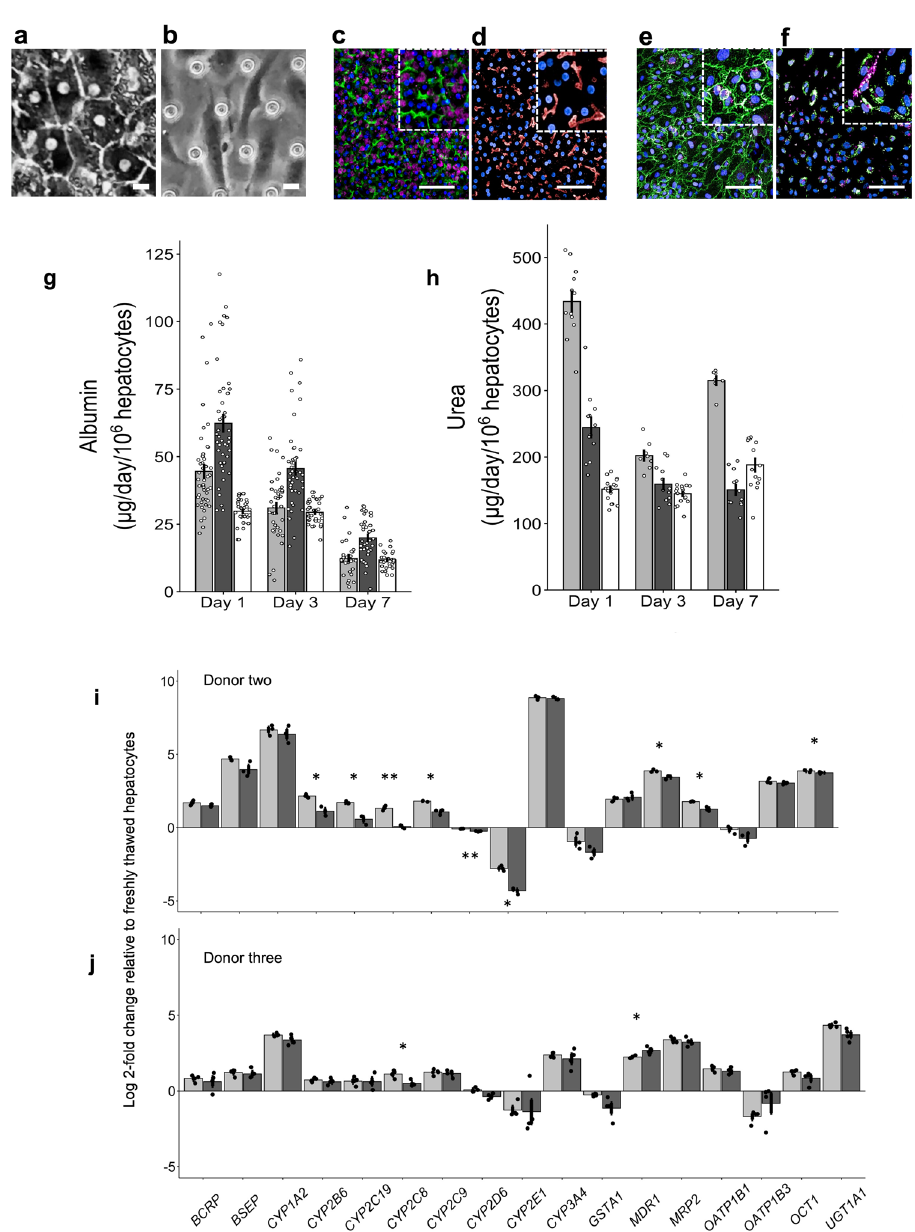
Fig. 3 Recapitulation of human liver structure and function in the Liver-Chip. Representative phase contrast microscopic images (scale bar represents 10 µ m) of hepatocytes in the upper channel of Liver-Chip ( a ) and non-parenchymal cells in the lower vascular channel (the regular array of circles are the pores in the membrane) ( b ). Representative immuno fl uorescence microscopic images showing the phalloidin stained actin cytoskeleton (green) and ATPB containing mitochondria (magenta) ( c ) and MRP2-containing bile canaliculi (red) ( d ). CD31-stained liver sinusoidal endothelial cells (green) and desmin- containing stellate cells (magenta) ( e ), and CD68 + Kupffer cells (green) co-localized with desmin-containing stellate cells (magenta) ( f ). All images in c – f show DAPI-stained nuclei (blue) and the scale bar represents 100 µ m with the inset at 5 times higher magni fi cation; albumin ( g ) and urea ( h ) levels in the ef fl uent from the upper channels of vehicle-treated Liver-Chips created with cells from 3 different donors (light and dark gray bars represent donor one and two respectively, white bars represent donor three) on days 1, 3, and 7 post-vehicle administration, measured by ELISA. Data are presented as mean ± standard error of the mean (S.E.M.). For each condition (i.e., speci fi c donor and day), the exact number of samples used to derive the statistics is: (i) Albumin: donor 1-day 1 ( n = 46), donor 2-day 1 ( n = 46), donor 3-day 1 ( n = 39), donor 1-day 3 ( n = 40), donor 2-day 3 ( n = 44), donor 3-day 3 ( n = 38), donor 1-day 7 ( n = 29), donor 2-day 7 ( n = 38), donor 3-day 7 ( n = 30); (ii) Urea: donor 1-day 1 ( n = 12), donor 2-day 1 ( n = 12), donor 3-day 1 ( n = 18), donor 1-day 3 ( n = 8), donor 2-day 3 ( n = 12), donor 3-day 3 ( n = 18), donor 1-day 7 ( n = 7), donor 2-day 7 ( n = 12), donor 3-day 7 ( n = 14). Levels of key liver-speci fi c genes in control Liver-Chips as determined by RNA-seq analysis on days 3 (light gray) and 7 (dark gray) post-vehicle administration with donor two ( i ) and donor three ( j ). Data are presented as mean Log2 (fold change) ± standard error of the TPM (Transcript Per Million) expression relative to the mean expression of the freshly thawed hepatocytes with n = 4 chips; statistical signi fi cance of values between day 3 and 7 was determined using a paired t -test; * p < 0.05, ** p < 0.01. For each time point (e.g., day 3 and 7), the sample size used to derive the statistics was n = 3 for donor two and n = 4 for donor